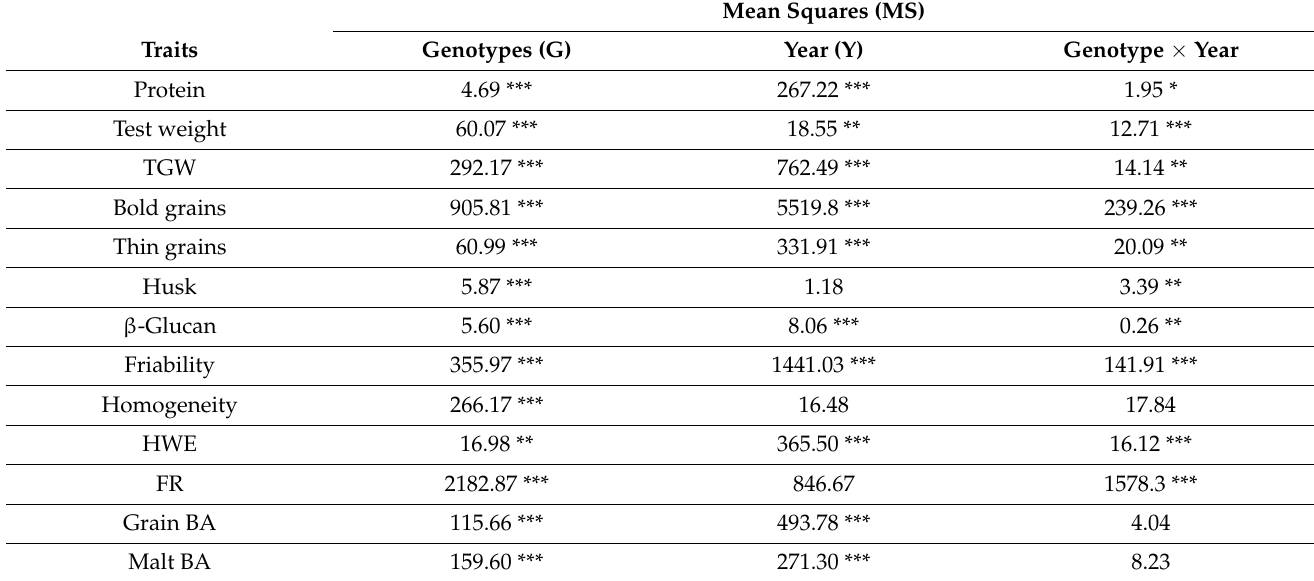
Table 5. Combined analysis of variance for nineteen genotypes for the studied